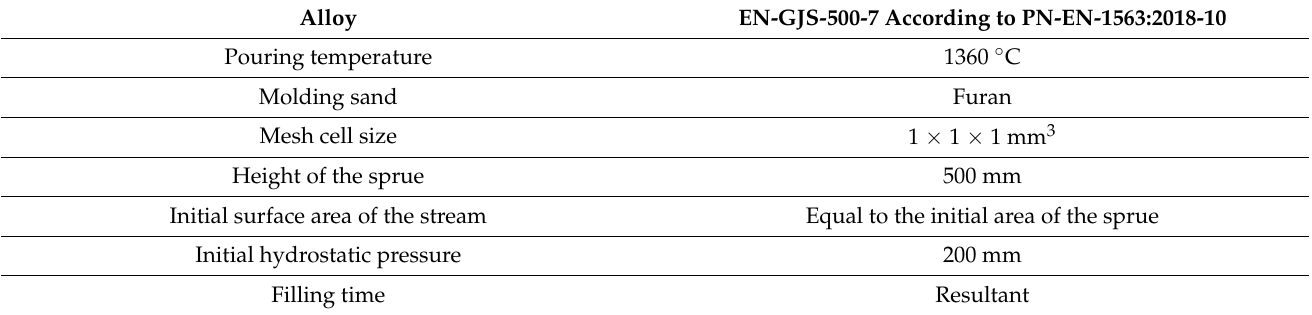
Table 4. Simulation parameters of short sprue